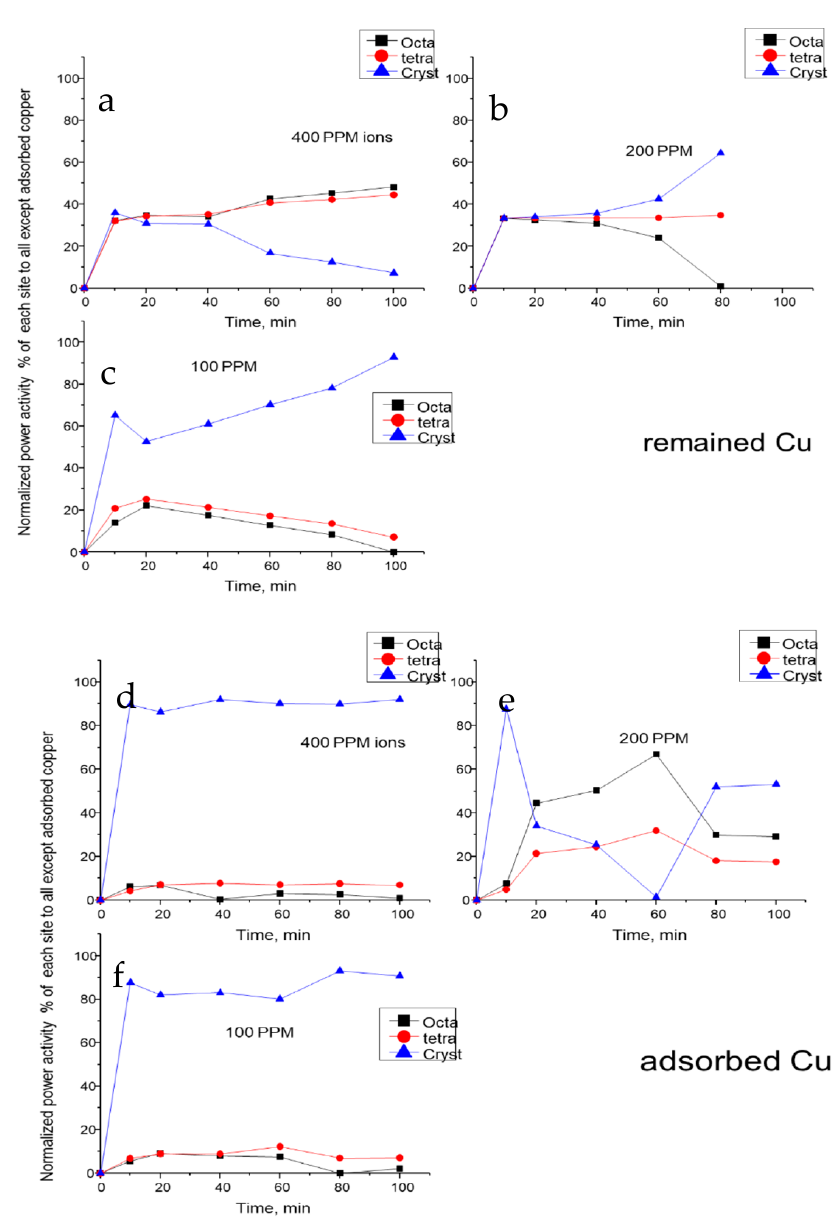
Figure 13. Effect of remained and adsorbed copper ions on the power activity map: ( a ) 400 ppm remained; ( b ) 200 ppm remained; ( c ) 100 ppm remained; ( d ) 400 ppm adsorbed; ( e ) 200 ppm adsorbed; ( f ) 100 ppm adsorbed.